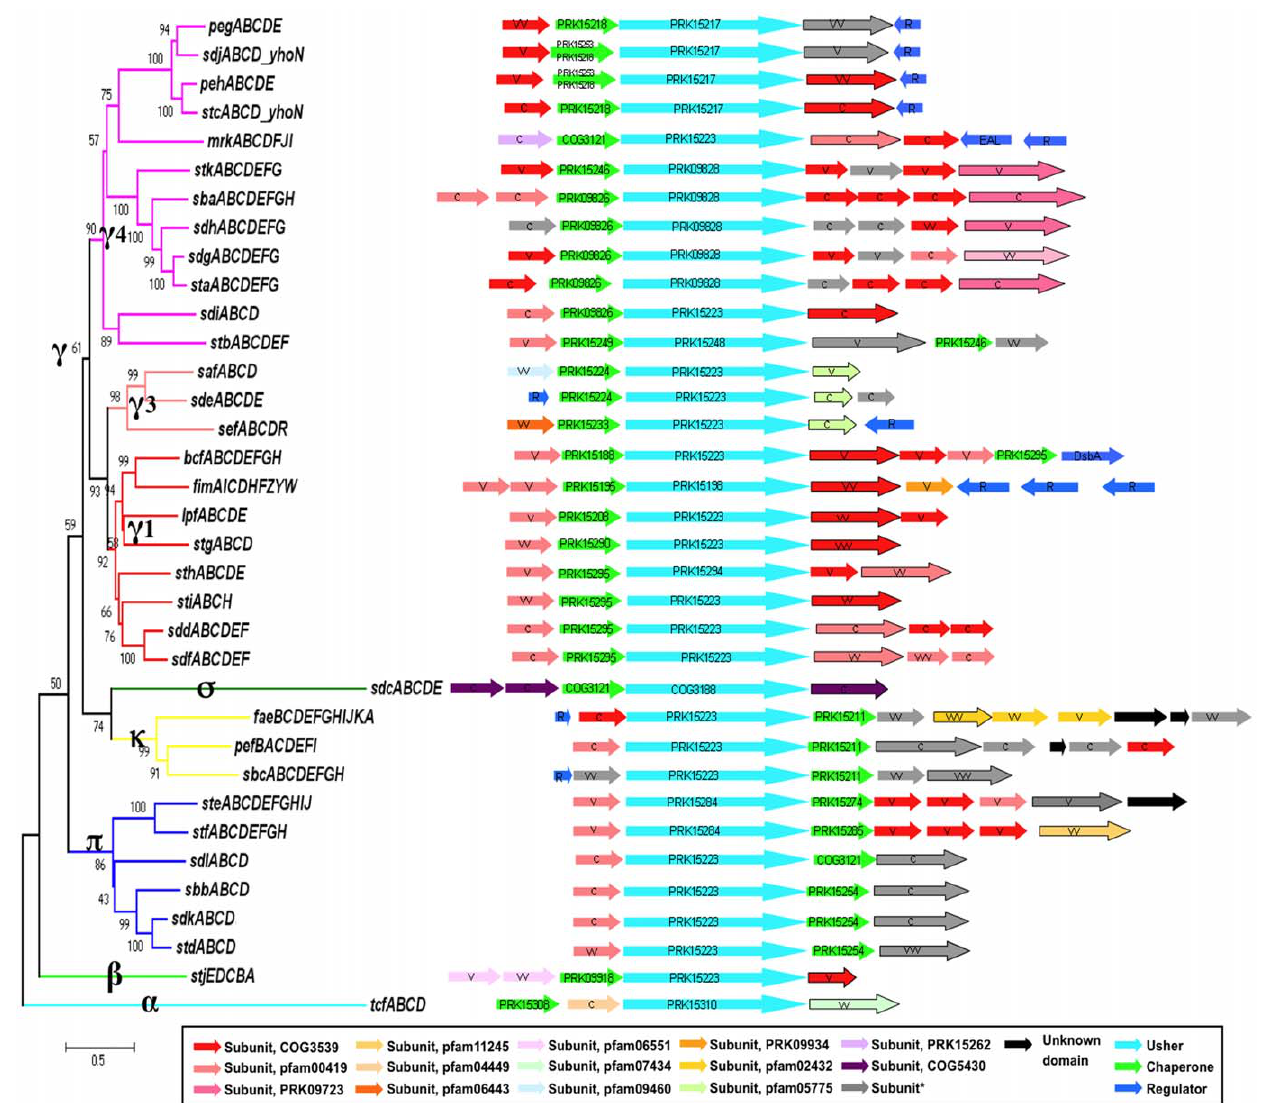
Figure 1. Chaperone-usher fimbrial gene clusters (FGCs) of Salmonella . A phylogenetic tree was built for 35 types of FGCs by using the amino acid sequences of the combined 950 usher proteins from 90 genomes (MEGA 5.0, as described in method). The FGCs were divided into five clades. The scale indicates the number of substitutions per amino acid. The bottom box lists different protein domain families. The asterisk indicates that some subunits were not picked by CDD or InterPro Scan, but (i) showed sequence similarity with other subunit(s) in the same gene clusters and (ii) were typically b -sheet-rich, as are all fimbrial subunits. Framed arrows are either known or predicted adhesins (as described in the text). C, V, VV, VVV were used to define the level of amino sequence variability for each subunit. C indicates subunits for which there was only one sequence available, or subunits lacking variants; V, VV or VVV indicated respectively # 1, 1–10 or . 10 detected variations per 100 amino acids.